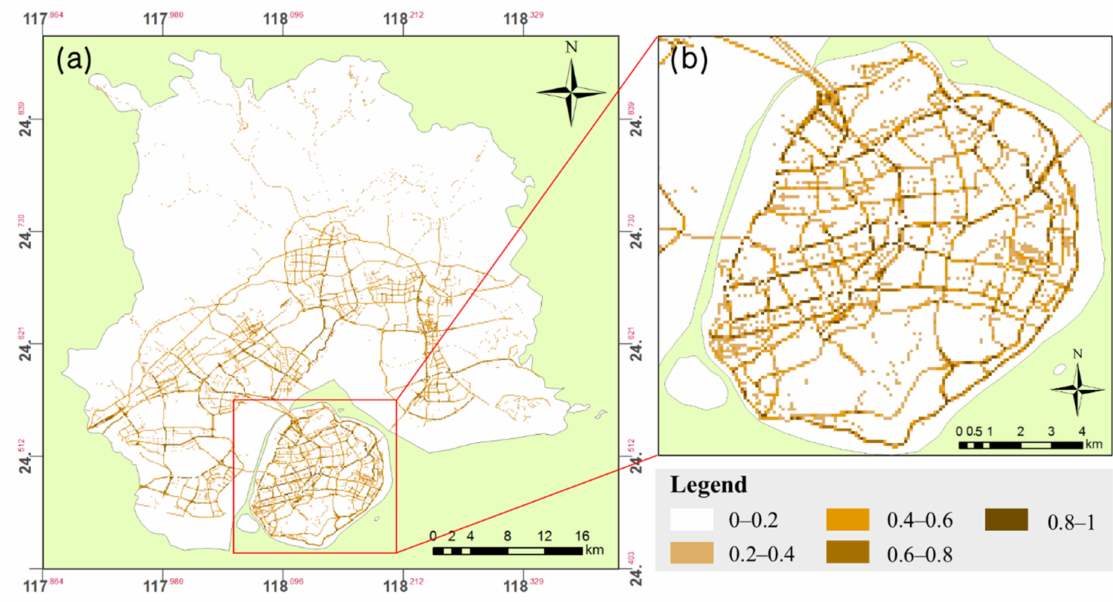
Figure 10. ( a ) Road grids; ( b ) Zoomed-in area of the red frame. (2) For Green Density Function: We used Gaofen7 data to construct the density function. In Gaofen7 satellite data, there are four bands which are RED, GREEN, BLUE, and NIR, we used these bands and grid vector data to calculate NDVI and the fractional green coverage. Specifically, the green density of each grid was calculated as the greenspace area divided by the grid’s area (Figure 11).